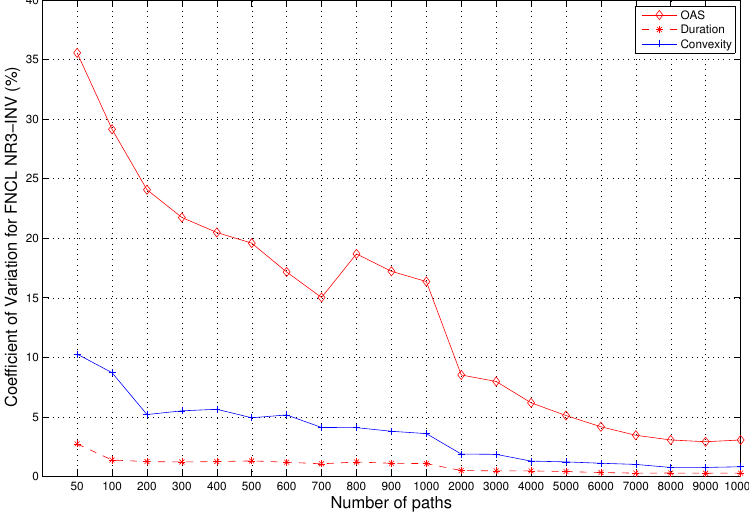
Figure 3. The Comparison of the convergence of OAS, DUR and effective convexity for the FNCL using NR3-inverse cumulative distribution function (INV). The vertical axis is for the coefficient of variation (%). The horizontal axis is the number of